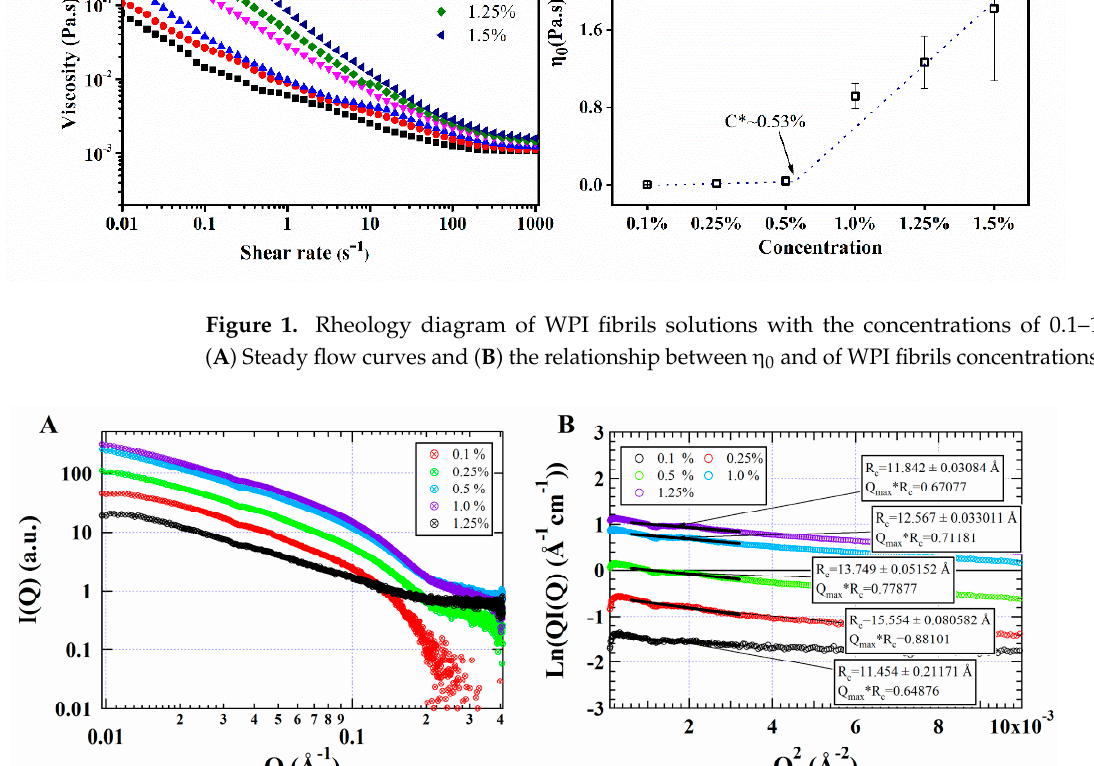
Figure 2. Small-angle X-ray scattering (SAXS) at different WPI fibrils concentration. ( A ) Profiles of SAXS intensity I(q) and ( B ) Guinner plots of WPI fibrils with different concentrations (0.1–1.25%) at pH 2.0.